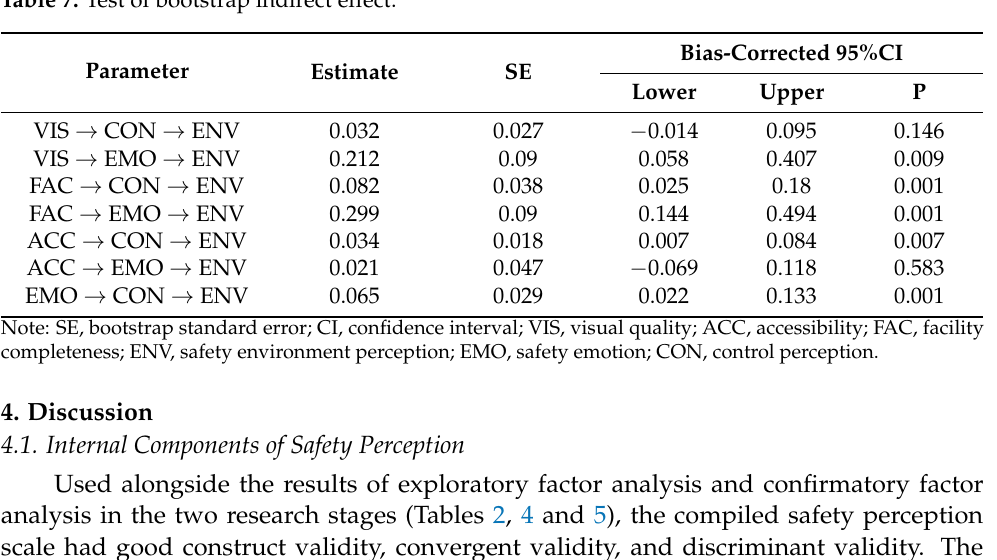
Figure 4. Structural equation modelling results. (Dotted line, hypothesis rejected; solid line, hypothe- sis accepted). Table 7. Test of bootstrap indirect